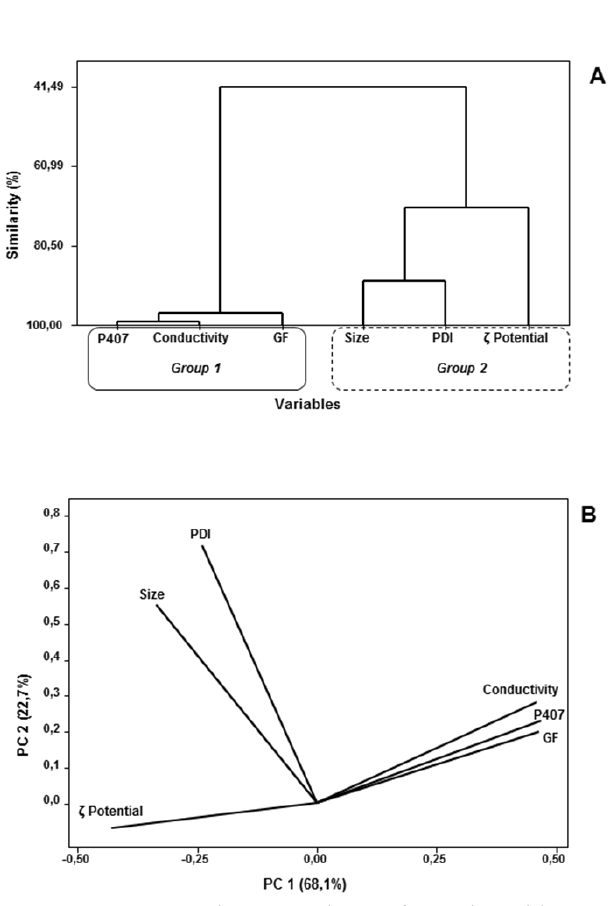
FIGURE 5 - HCA and PCA analyses of samples with GF - (A) dendrogram of the GF-P407 mixture samples using the single linkage method and Mahalanobis distance; (B) Loading plots (PC1 versus PC2) from variables. Group 1: P407 (polymer concentration), conductivity, GF solubilized; Group 2: particle size, PDI (polydispersity index), and ζ